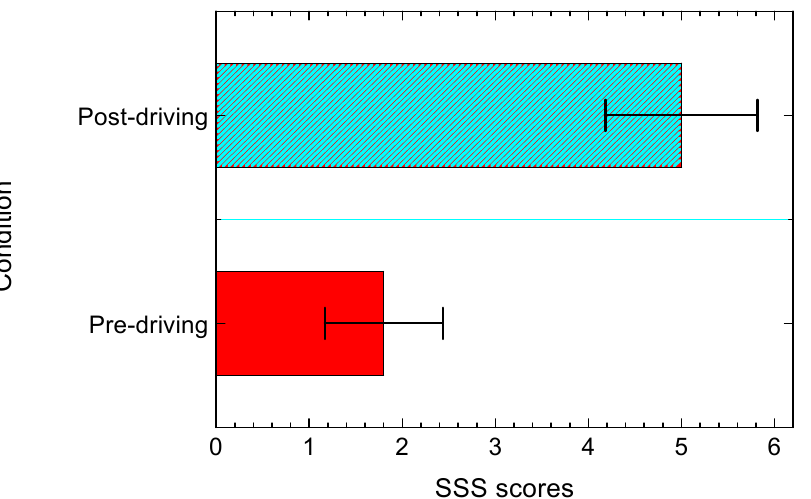
Figure 2. The variation in participants’ SSS scores in different experimental conditions.